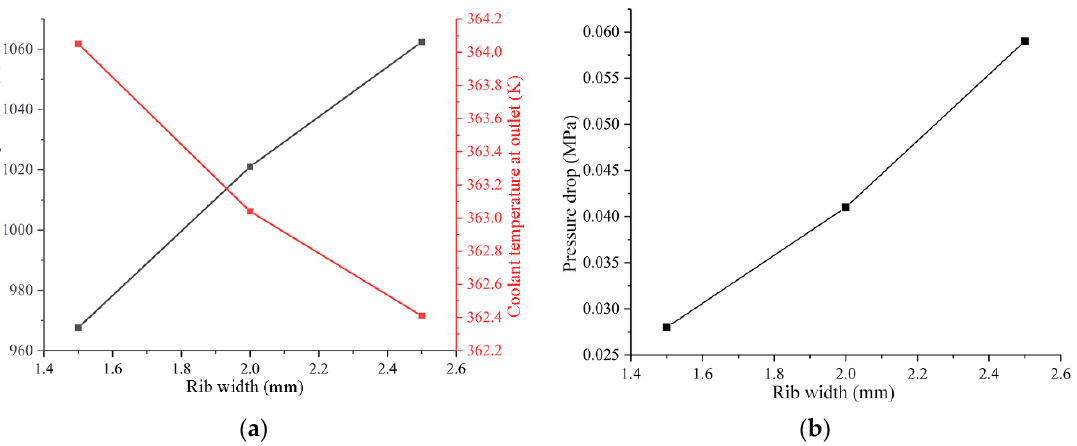
Figure 20. Temperature and pressure drop at different rib widths. ( a ) Wall temperature and coolant temperature; ( b ) pressure drop at different rib heights.